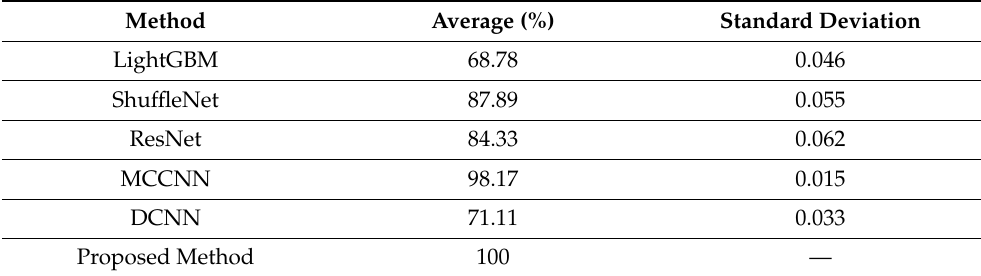
Table 3. Average accuracy and SD of the different